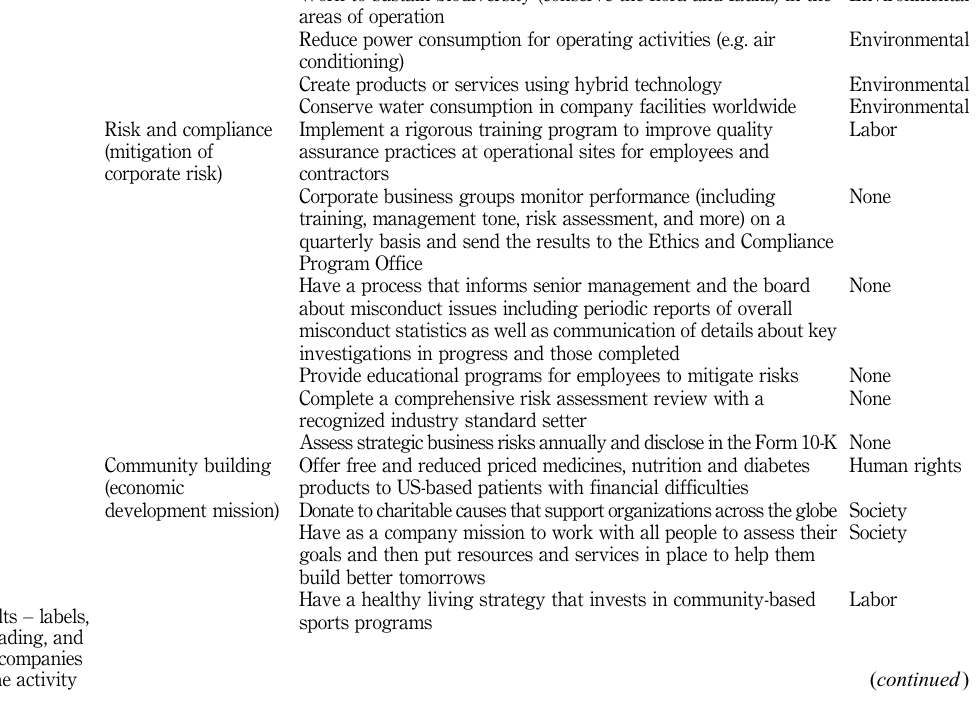
Table V. Factor results – labels, activities loading, and GRI where companies classified the